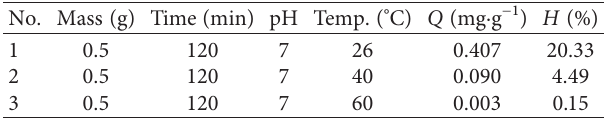
Table 6: Effect of temperature on the Cr (VI) ion adsorption